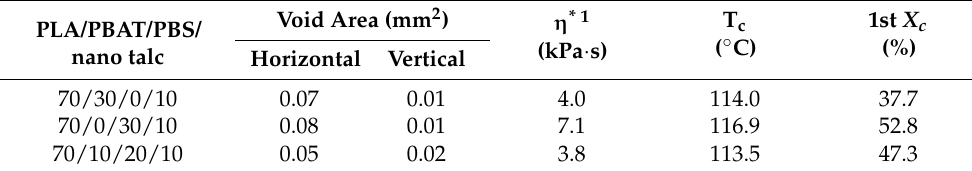
Table 7. Void area and properties of PLA/PBAT/PBS/nano talc composite 3D prints.